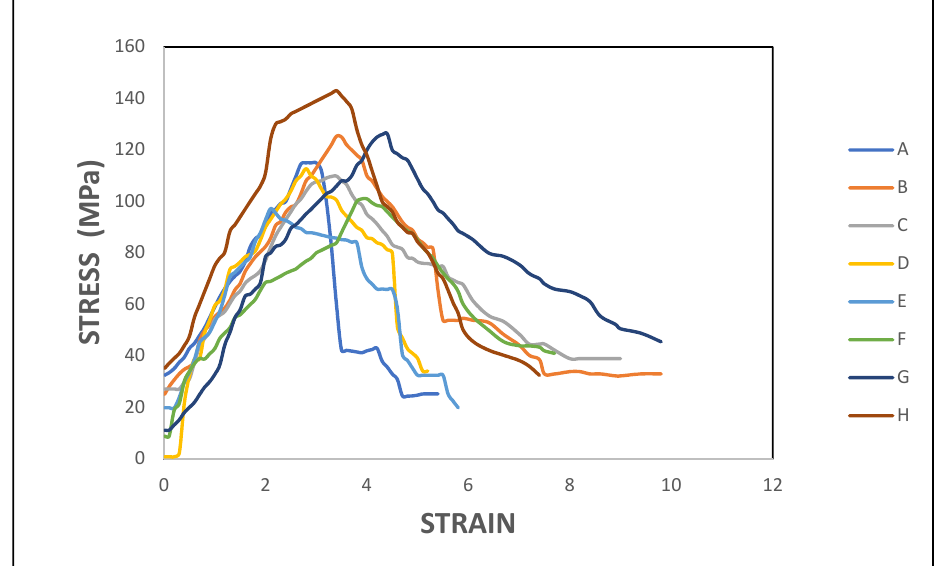
Figure 9. Flexural stress vs. strain for composite.